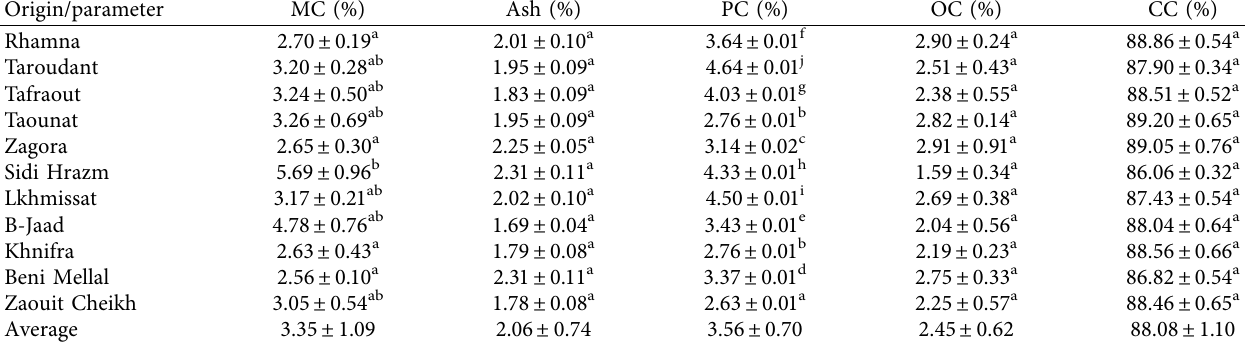
Table 2: Proximate composition of the studied Z . lotus fruits across 11 Moroccan origins (results are expressed as mean values ± standard deviation of percentage of moisture content (MC), ash content (AC), protein content (PC), oil content (OC), and carbohydrate content (CC)).